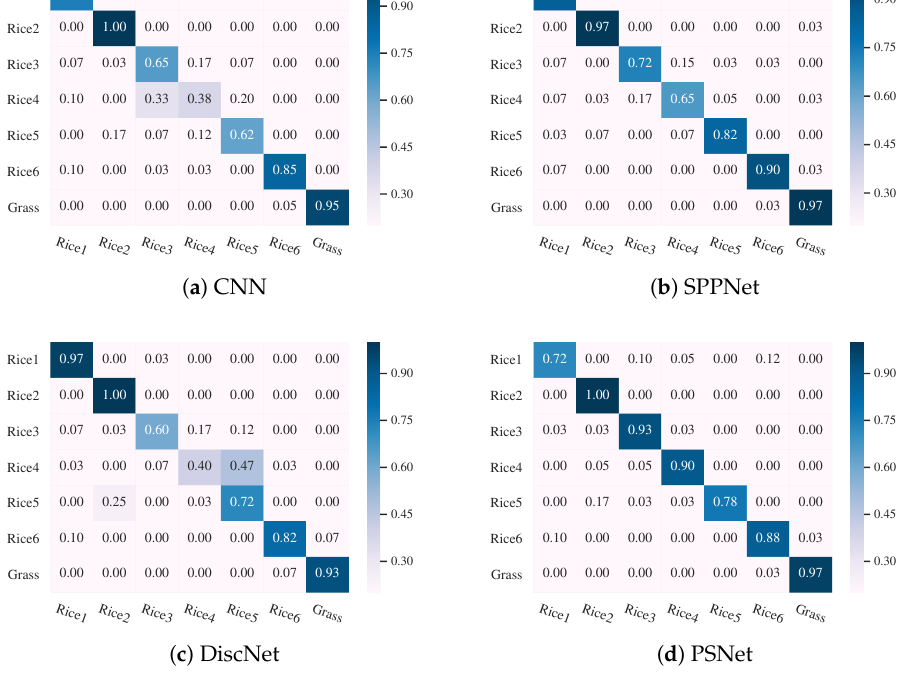
Figure 16. Confusion matrices for the Rice